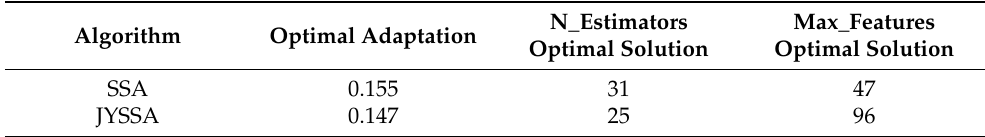
Table 3. Optimal parameters of 186-band SSA and